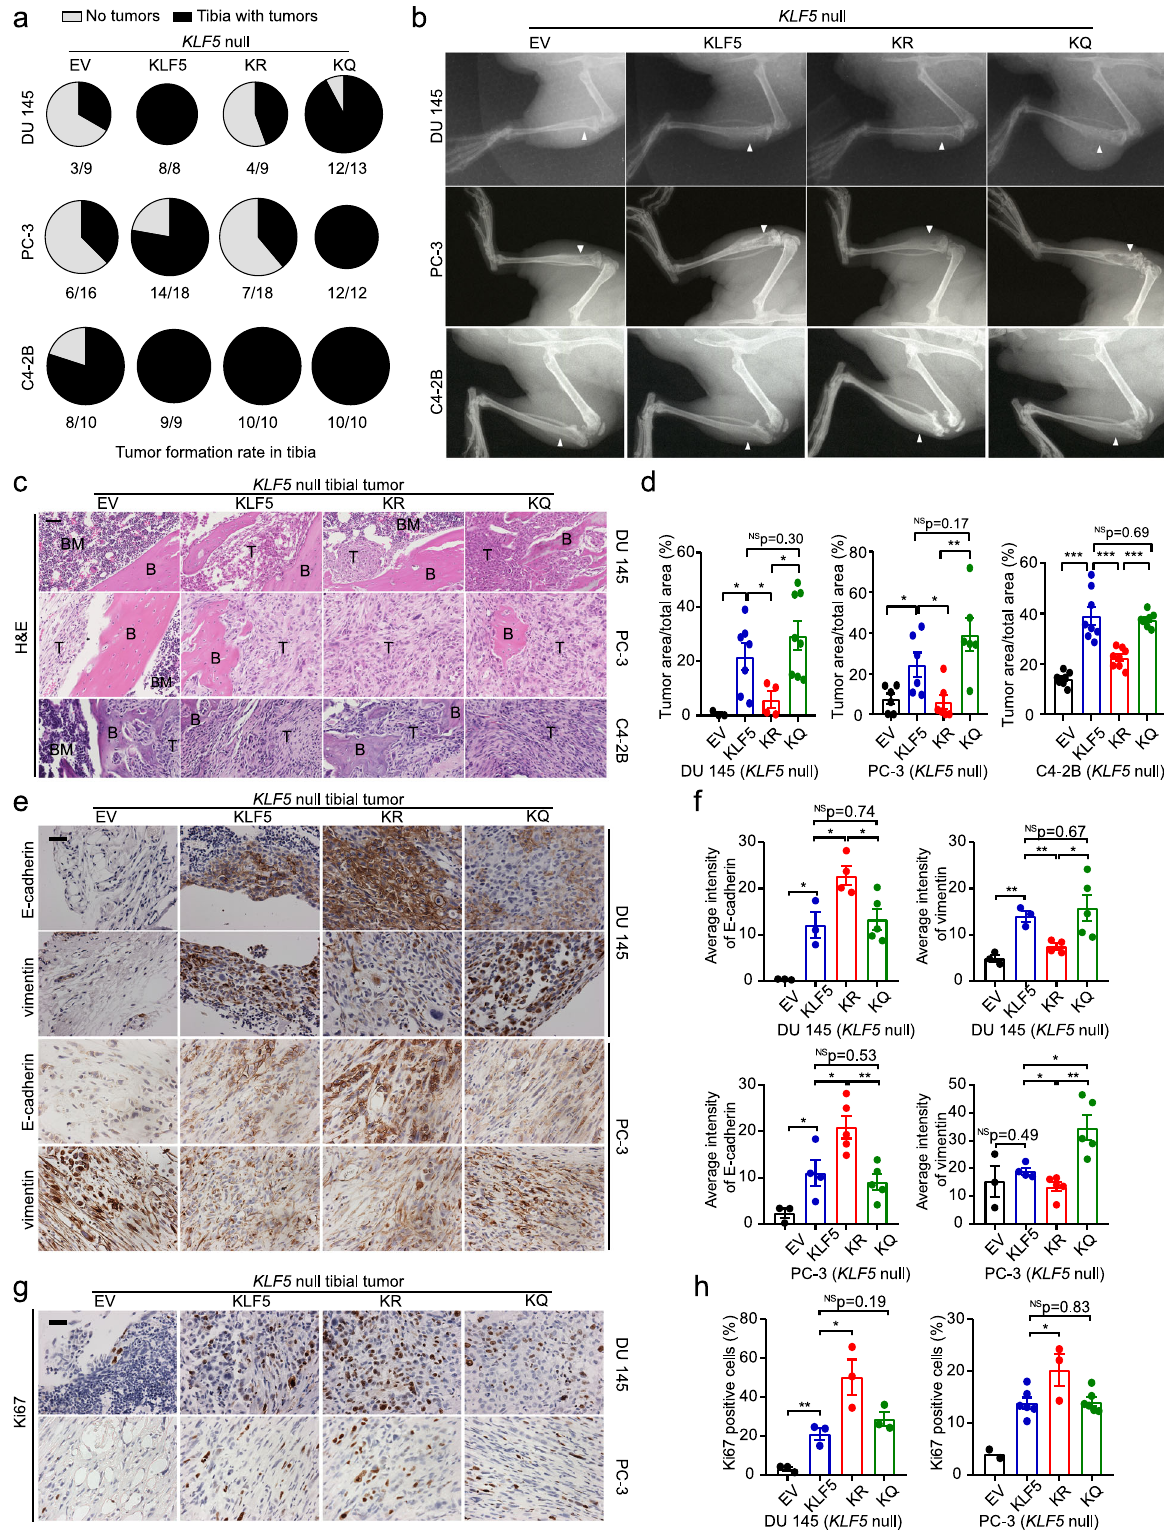
Acetylation of KLF5 in tumor cells is required for osteoclast differentiation during bone metastasis . In addition to tumor cell proliferation, bone metastatic growth of PCa cells also causes bone lesions via their interactions with the bone microenviron- ment including both osteoclasts and osteoblasts; and both osteolytic and osteoblastic lesions release factors that